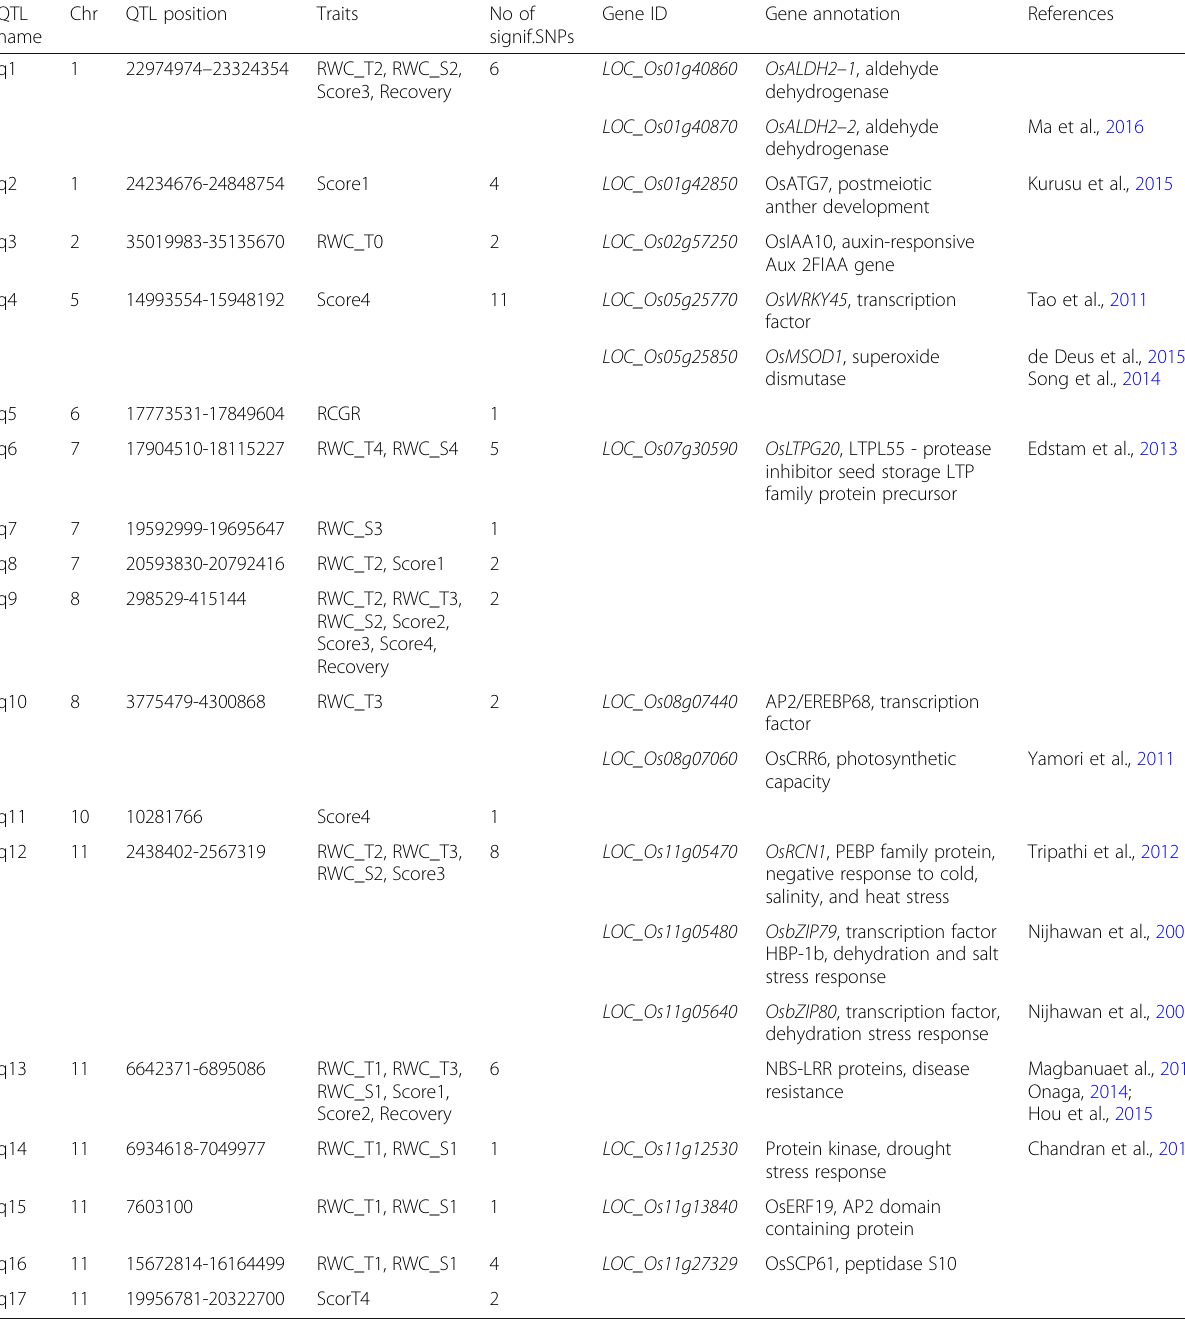
Table 4 List of candidate genes located within the identified